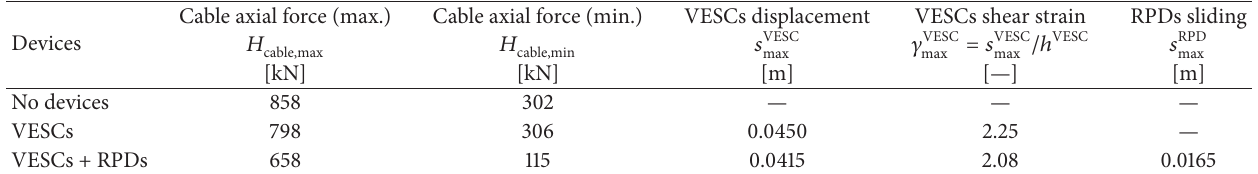
Table 3: Numerical results of dynamic analyses (ABAQUS). Level